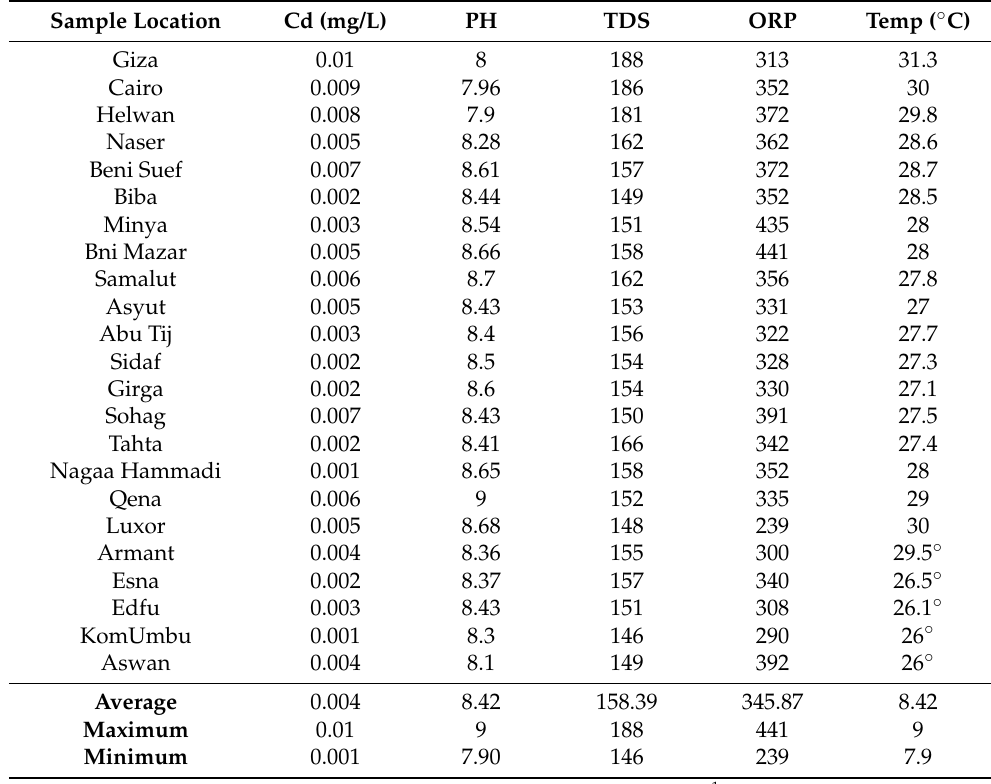
Table 5. Cadmium concentration in water (mg L − 1 ) and water parameters of Nile River sediments (PH, TDS, ORP,